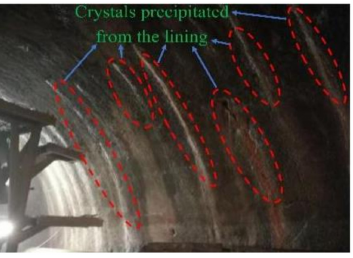
Figure 2. Precipitated crystal of tunnel lining.